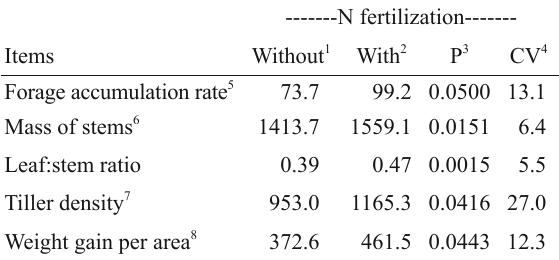
Orthogonal contrasts for forage accumulation rate, mass of stems, leaf:stem ratio and tiller density of Alexandergrass grazed by heifers according to N